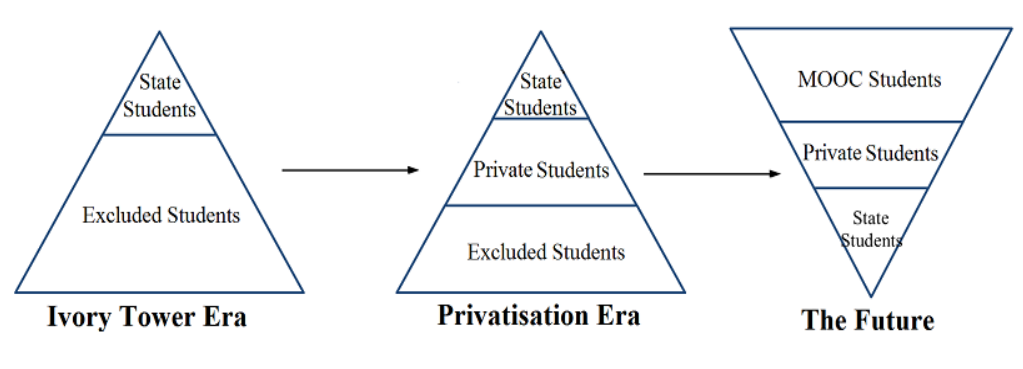
Figure 1. Perspectives of higher education access in Africa: past, present and